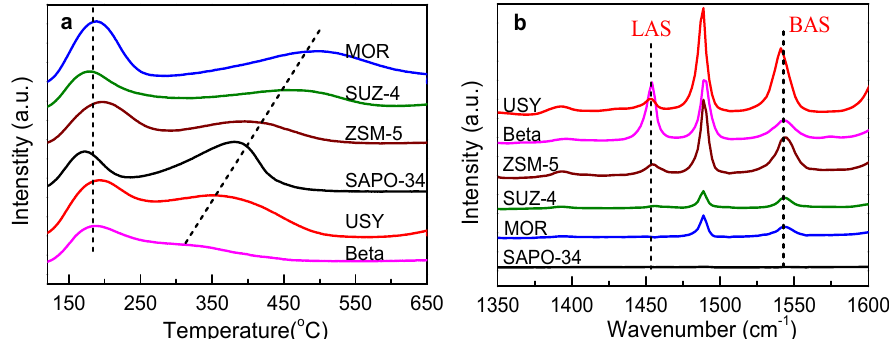
Figure 2. The temperature-programmed ammonia desorption (NH 3 -TPD) profiles ( a ) and pyridine adsorption (Py-IR profiles) ( b ) of various zeolites.